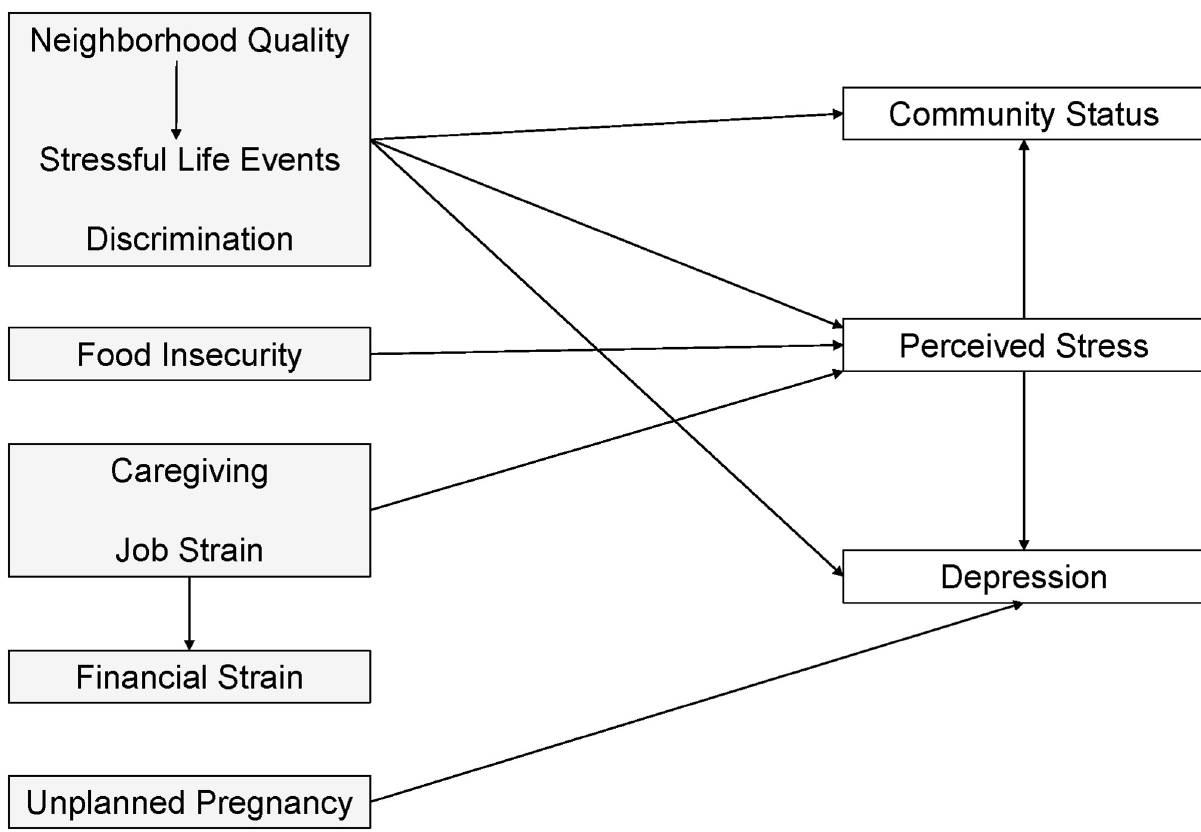
Fig 1. Hypothesized pathways between psychosocial stressors and responses to stress. Gray boxes indicate psychosocial stressor measures and white boxes indicate responses to psychosocial stress.